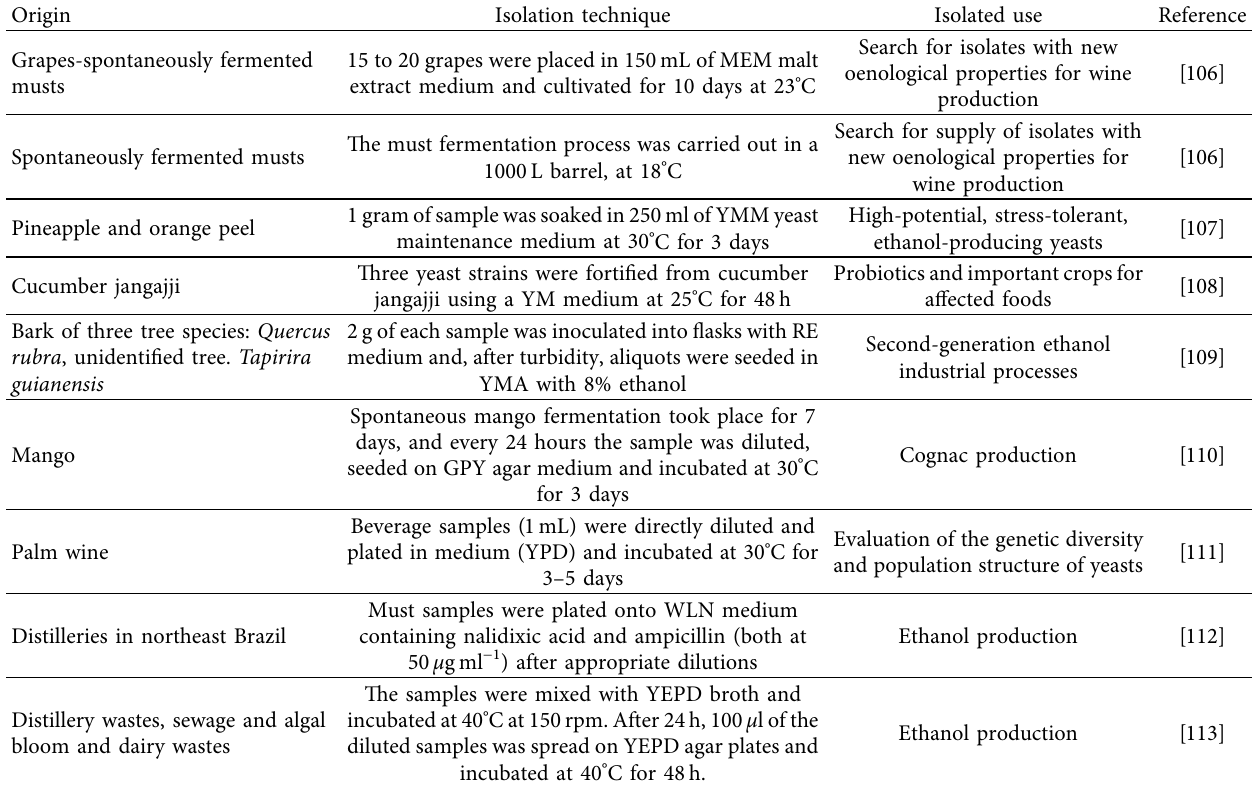
Table 1: Different strategies used for the isolation of Saccharomyces cerevisiae from environmental